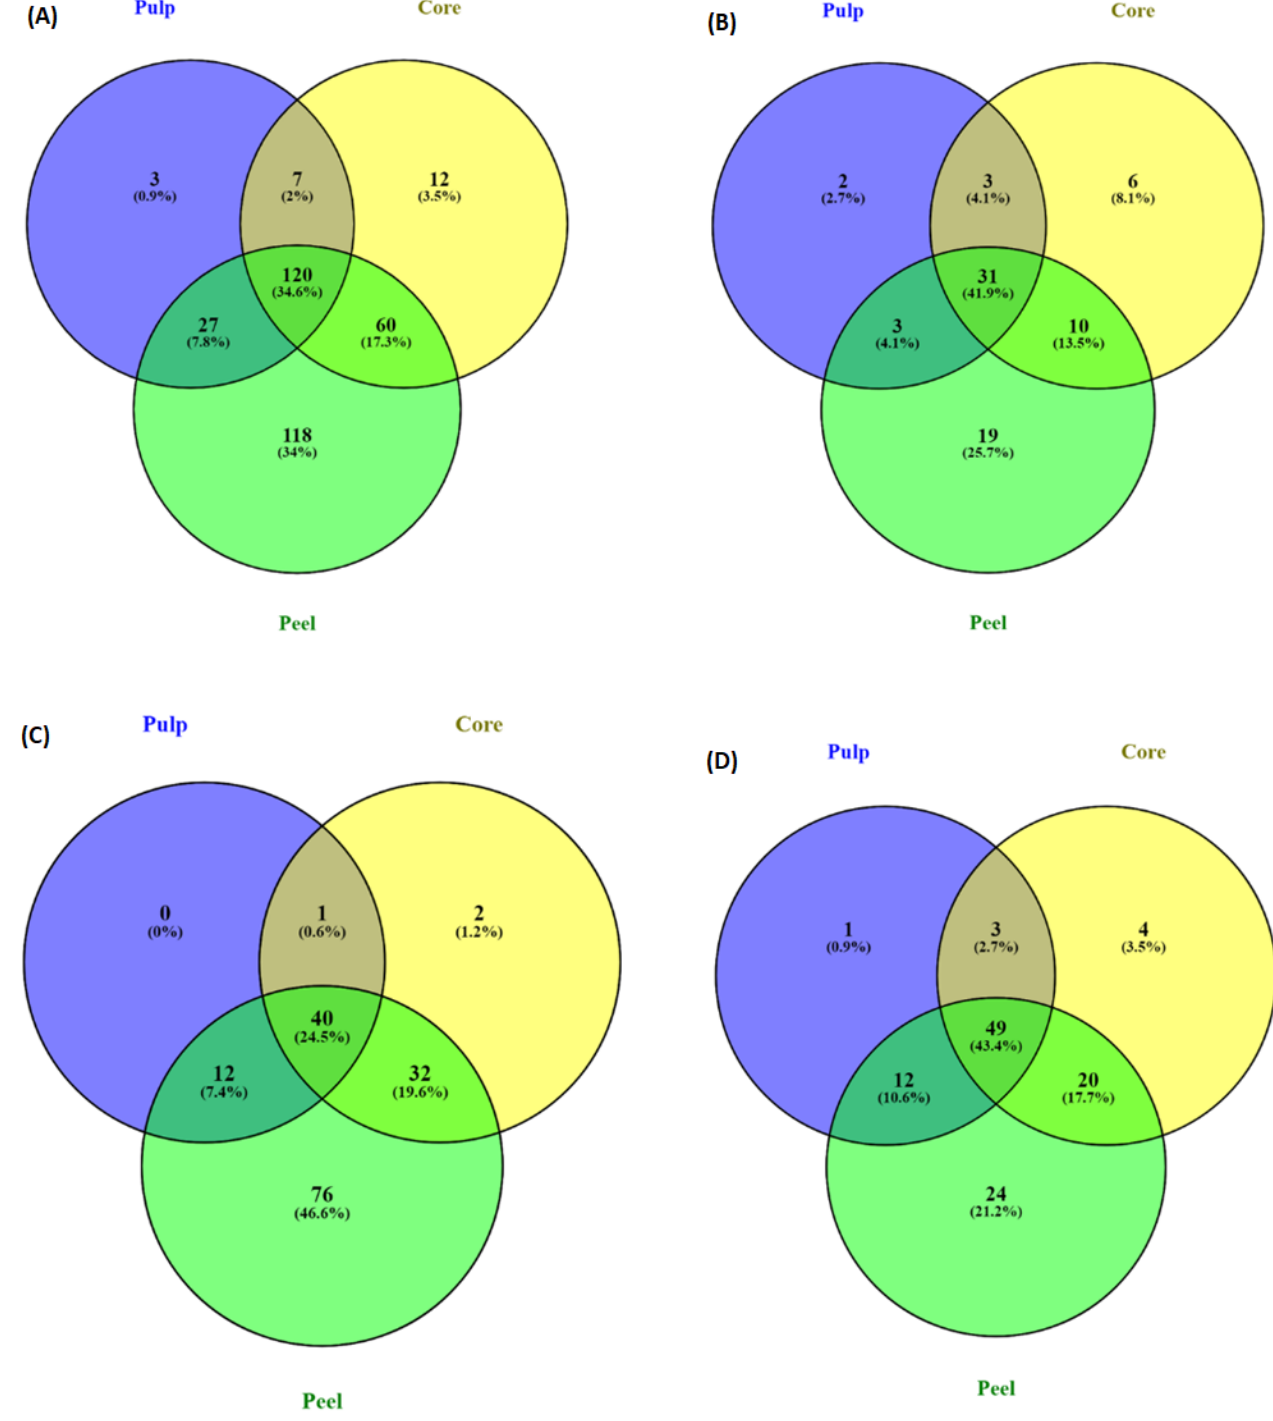
Figure 2. Venn diagram of the total phenolic compounds presented in different kiwifruit parts. ( A ) A comparison of the total phenolic compounds present in different kiwifruit parts. ( B ) A comparison of the total phenolic acids present in different kiwifruit parts. ( C ) A comparison of the total flavonoids present in different kiwifruit parts. ( D ) A comparison of the total other polyphenols present in different kiwifruit parts. AH: Australian-grown Hayward kiwifruit. NZ: New Zealand-grown Zesy002 kiwifruit. OH: New Zealand-grown organic Hayward kiwifruit.